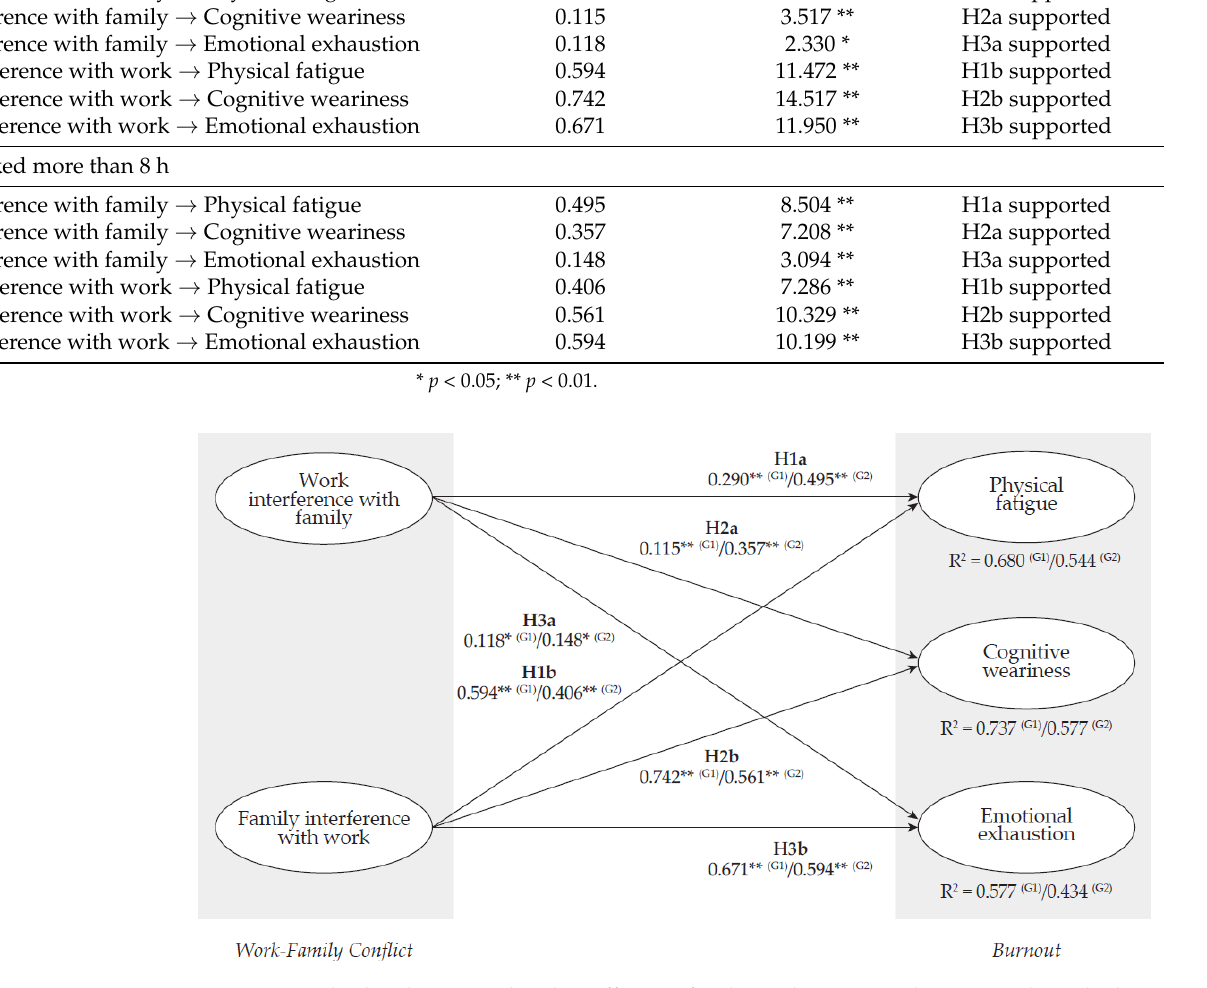
Figure 3. Standardized structural path coefficients for the multigroup analysis. G 1 : teleworked 8 or